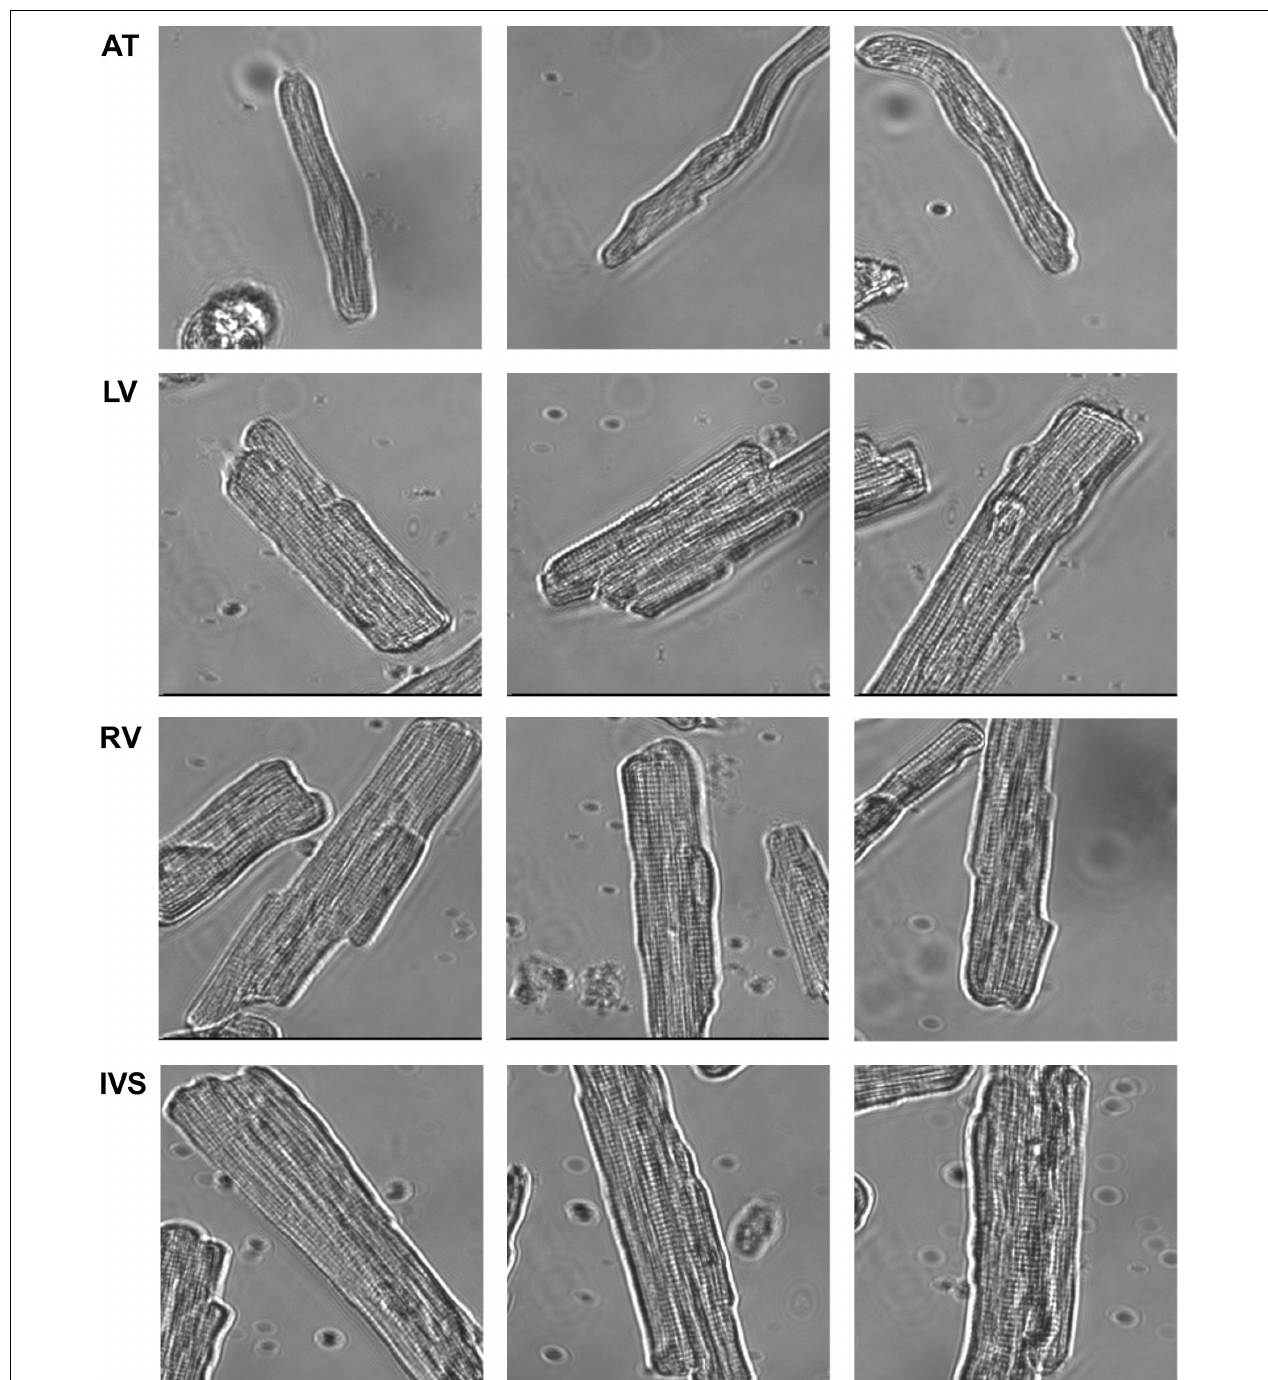
FIGURE 3 | Representative cells from each cardiac region. Cells from atrium (AT) were markedly thinner and shorter than cells from left ventricle (LV) and right ventricle (RV) and interventricular septum